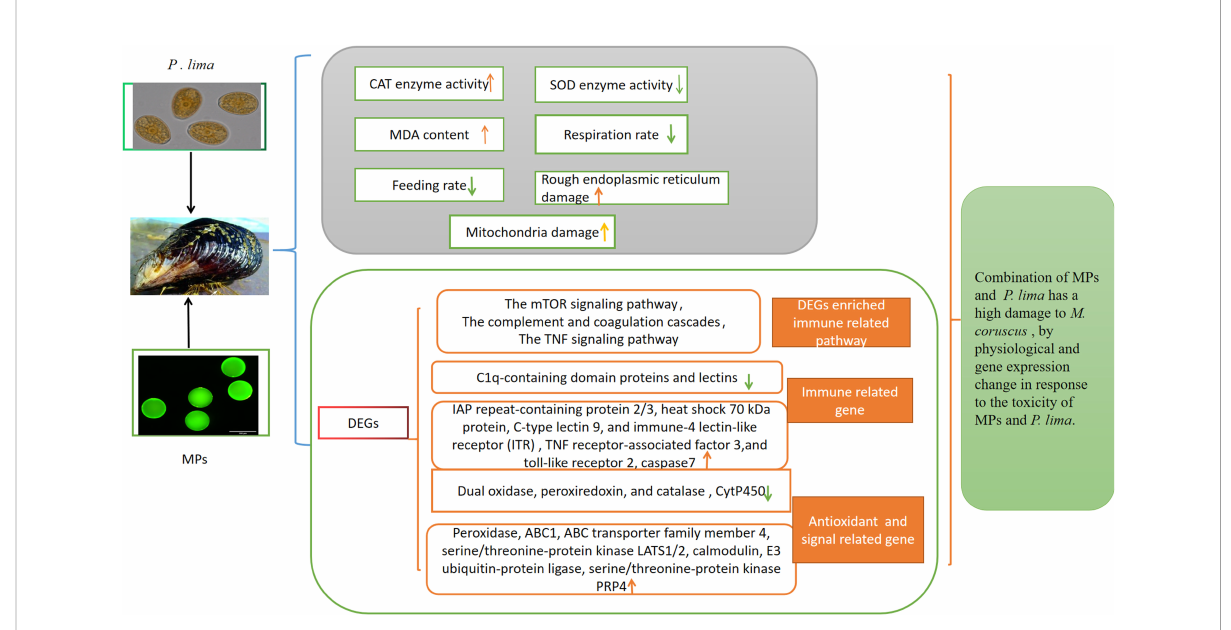
FIGURE 9 Summary map of M. coruscus to MPs and P. lima alone and combination